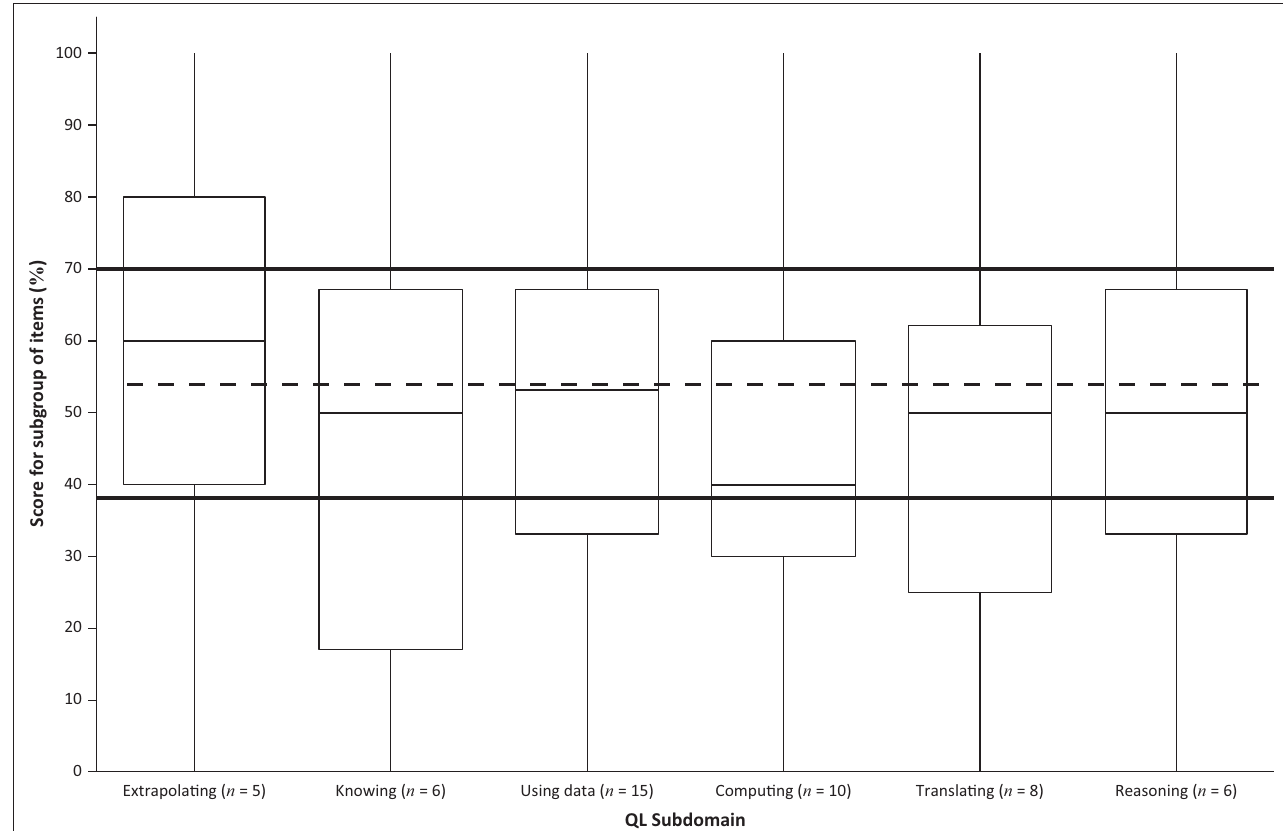
FIGURE 8: Distributions of the scores of the entire sample for each subgroup of items based on the main competency they assess.